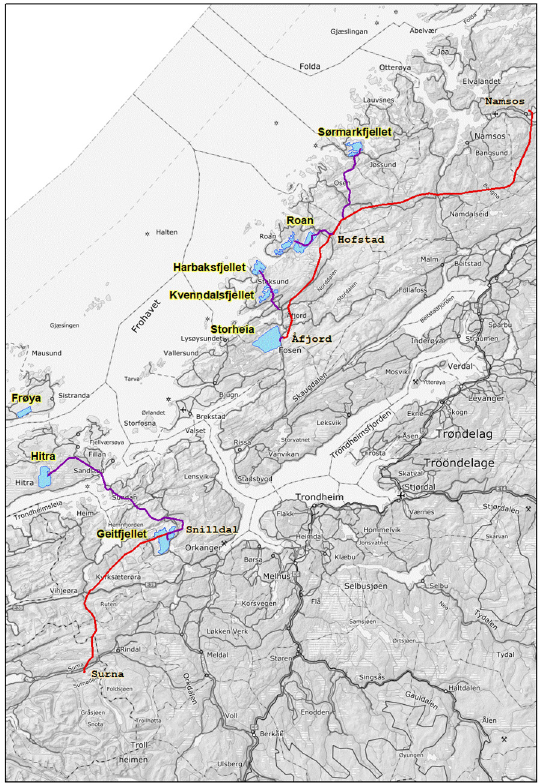
Figure 1. The study area with the eight wind farms (blue) with area names (yellow), and the 420 kV (red) and 132 kV (violet) power lines. The influence area for eagle owls is defined to be up to five kilometers from these constructions, and reference areas are further away. Nearly no new powerlines were constructed in